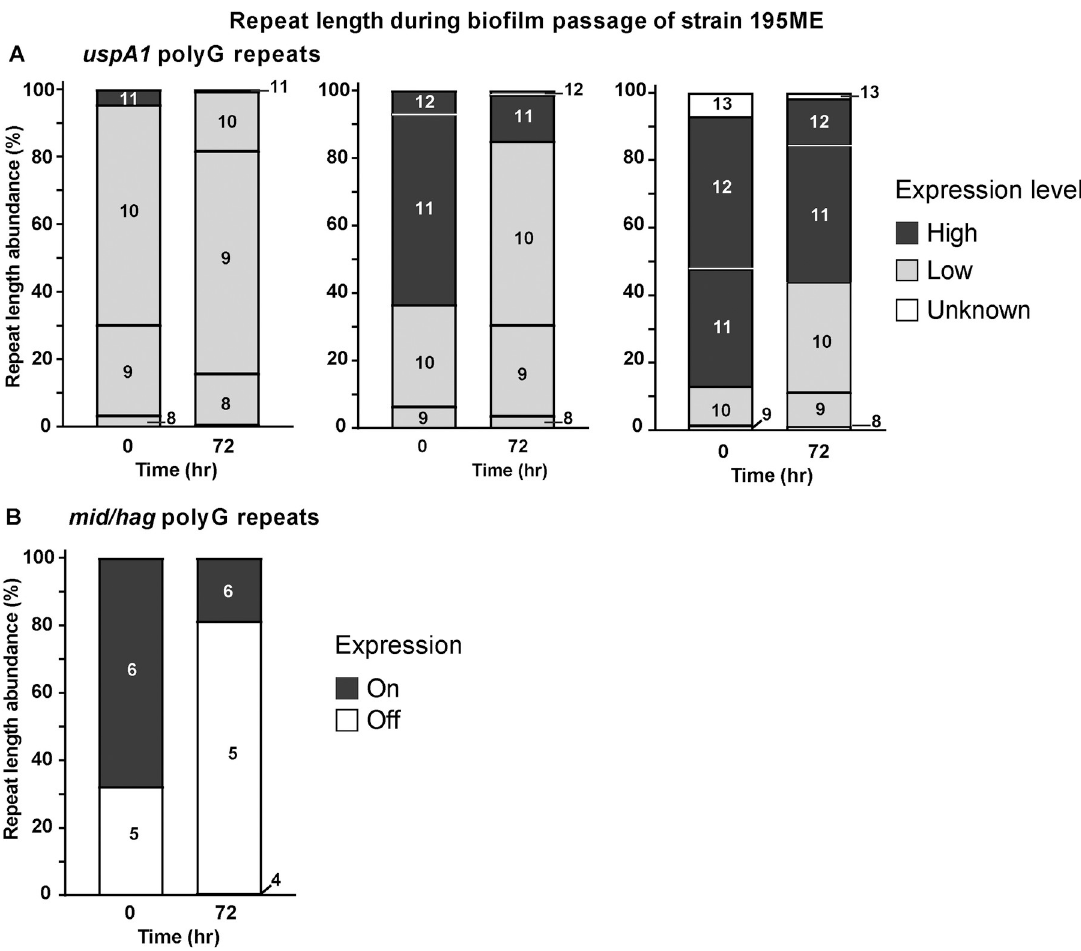
Fig 3. Differences in uspA1 and mid/hag repeat tract lengths during biofilm passaging. Fragment length analysis of M . catarrhalis 195ME populations passaged in biofilm formation assays for 3 consecutive days. Each graph shows a different starting population, enriched for (A) 10, 11 or 12 repeats in uspA1 , or (B) 6 repeats in mid/hag . Stacked bars indicate the proportion of each repeat length found in pre-passaging (0 hrs) and post-passaging (72 hrs) populations. For uspA1 , bar colour indicates the relative mRNA level correlated with each repeat length: black, high mRNA level; grey, low mRNA level; white, unknown mRNA level ( uspA1 13 repeat variant only). For mid/hag bar colour indicates expression phase: black, on; white, off. Assays were carried out in biological triplicate, and proportions averaged. See S1 Fig for individual